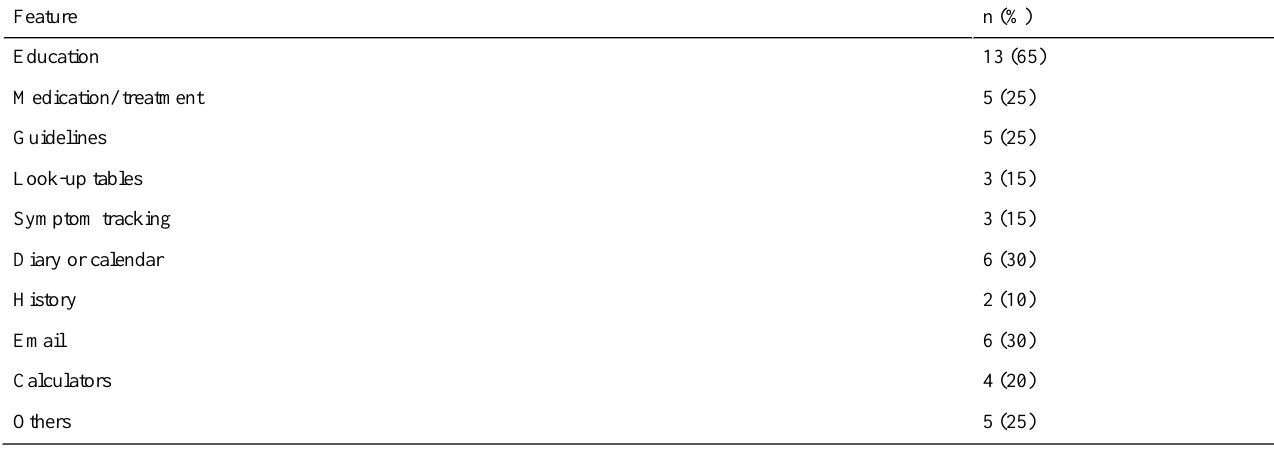
Table 2. The number of downloaded apps containing the identified common features